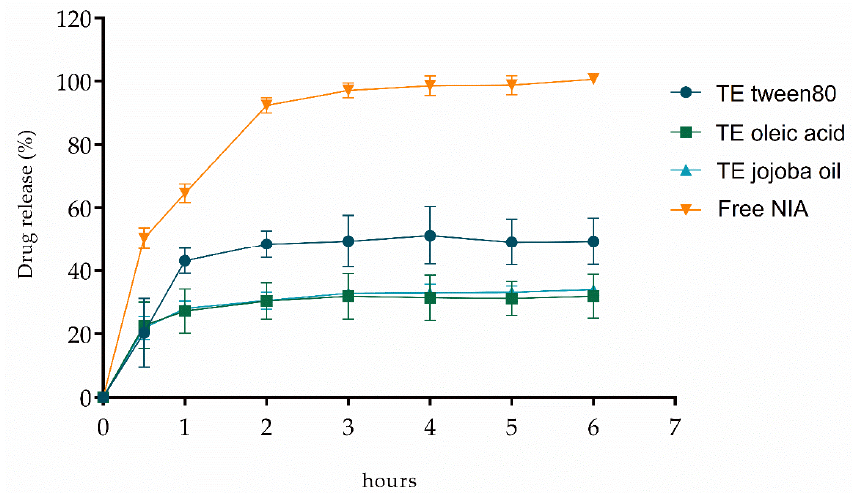
Figure 3. Drug release profile of NIA as free drug and loaded in tween 80, oleic acid, and jojoba oil transethosomes. Each value represents the mean ± SD ( n ≥ 2).